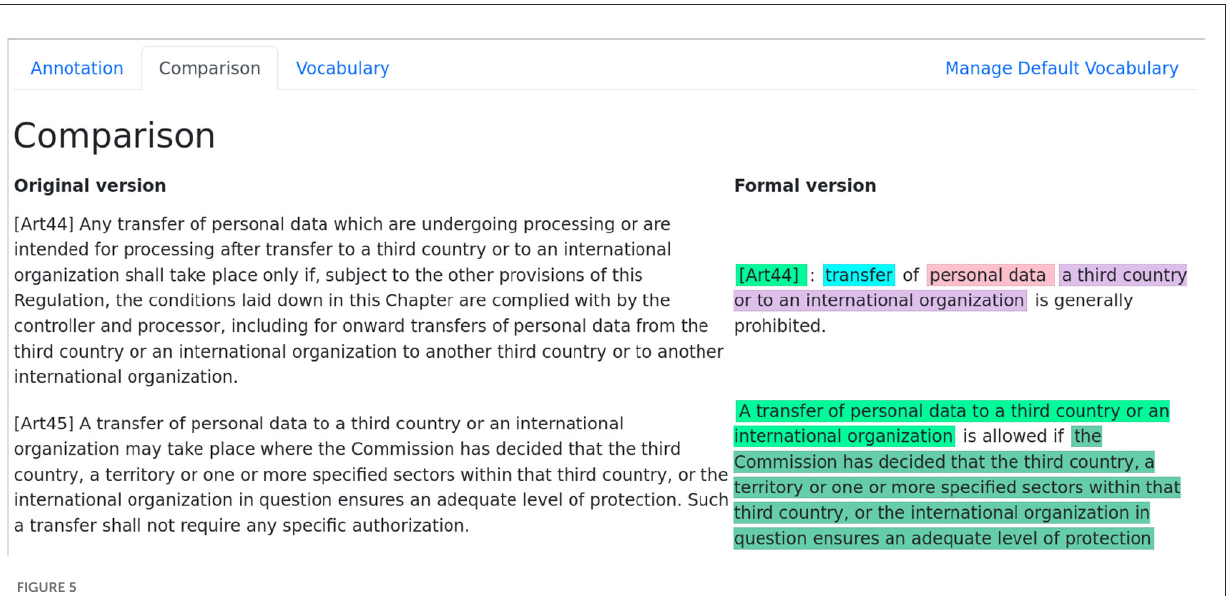
FIGURE5 Reverse translation for articles 44 and